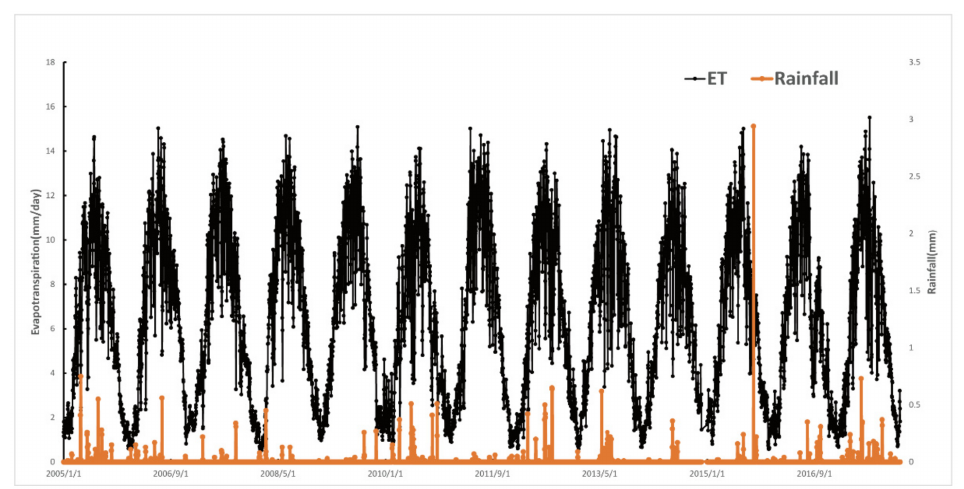
Figure 4. Rainfall and daily reference evapotranspiration from the simulation period